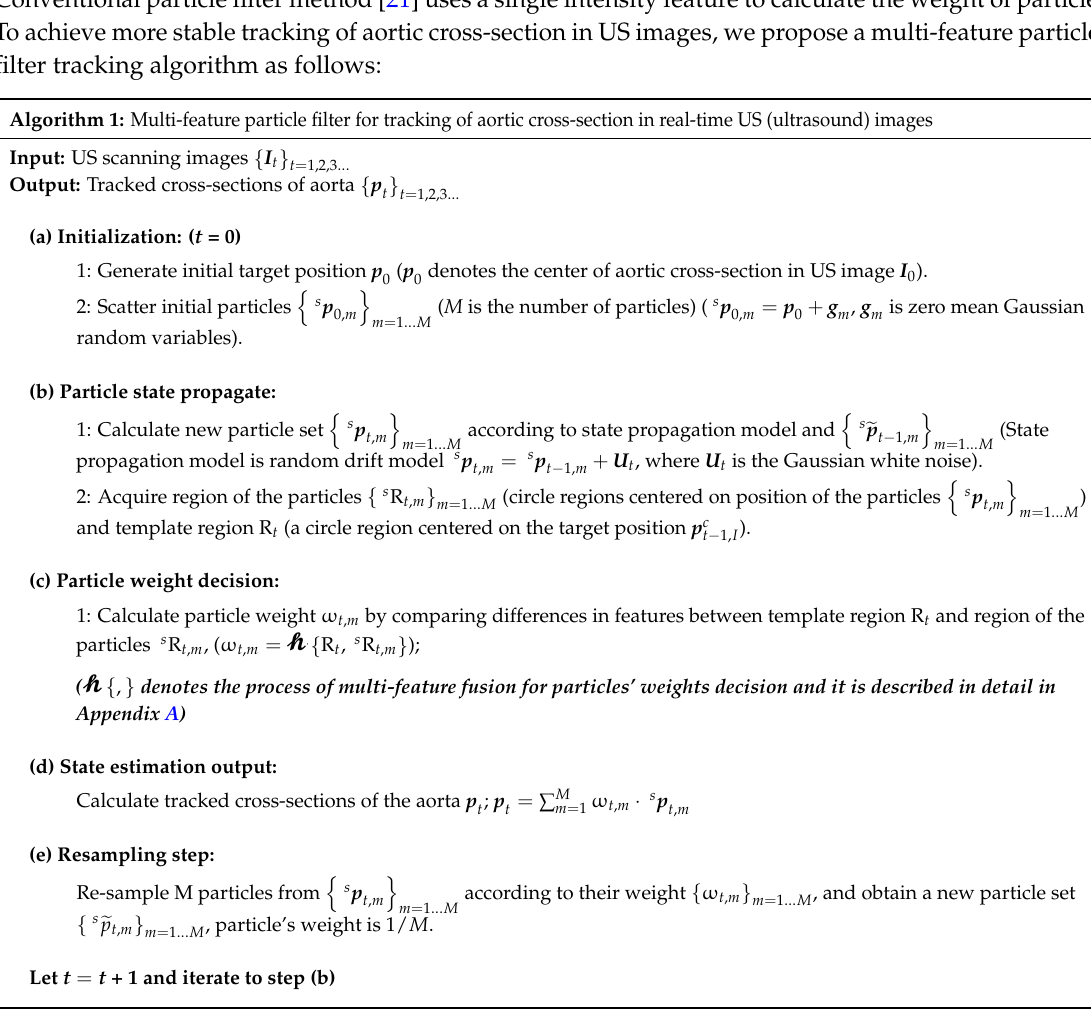
Algorithm 1: Multi ‐ feature particle filter for tracking of aortic cross ‐ section in real ‐ time US ( ultrasound ) images